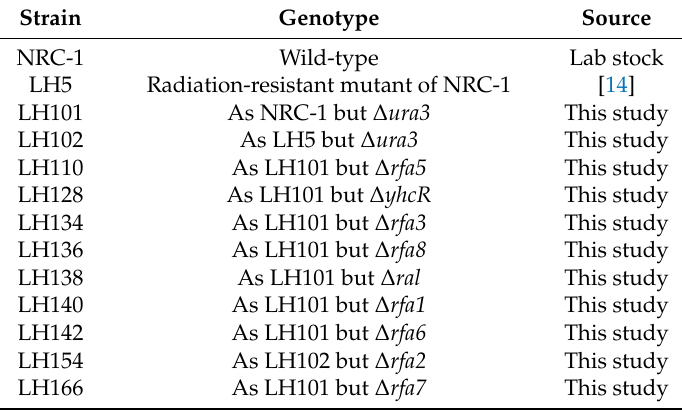
Table 2. Hbt. salinarum strains